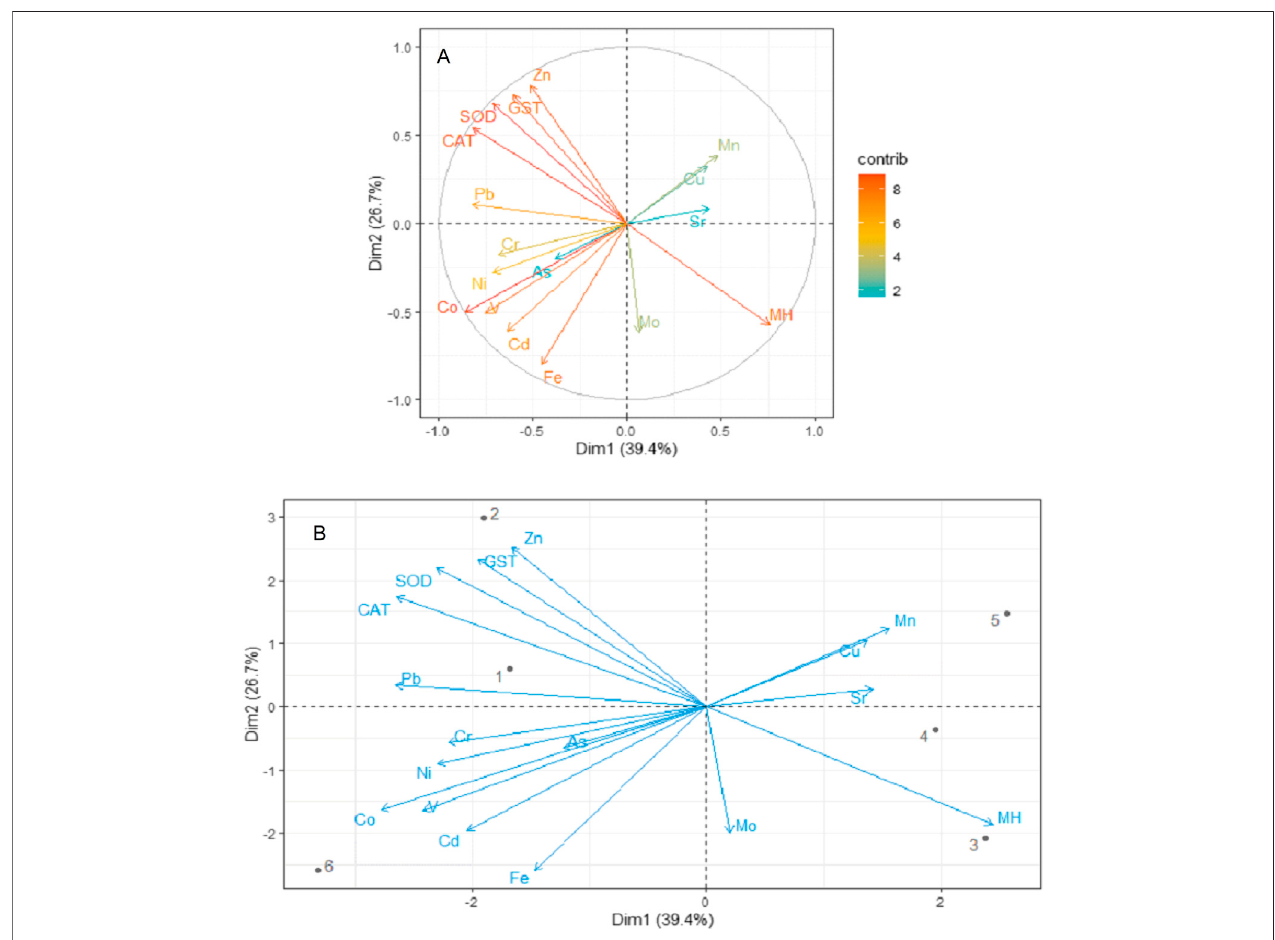
FIGURE6| Principalcomponentanalysisfortherelationshipbetweenmetalconcentrationsandantioxidantsinthemangroves. (A) Contributiontodimensionsand total variation and (B) biplot. Key: CAT, catalase; GST, glutathione S-transferase; SOD, superoxide dismutase; MH, mangrove height; 1, Al Lith; 2, south Jeddah; 3, Dahban; 4, Thuwal; 5, Rabigh; 6, Mastorah.